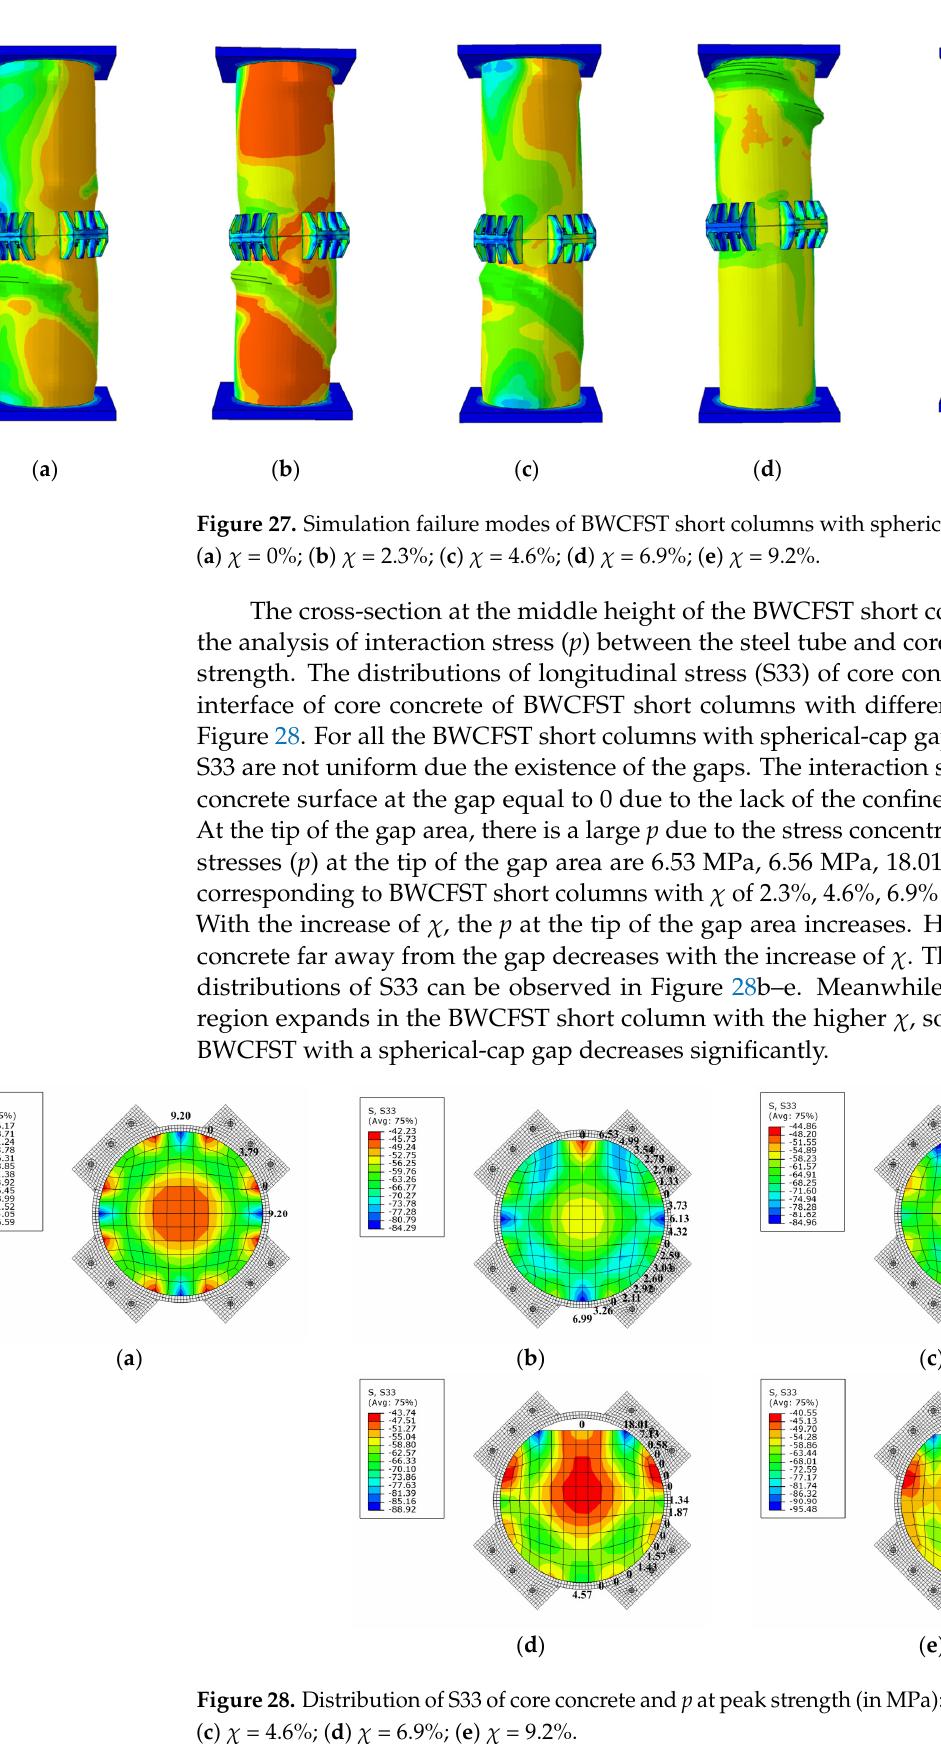
Figure 28. Distribution of S33 of core concrete and p at peak strength (in MPa): ( a )  = 0%; ( b )  = 2.3%; ( c )  = 4.6%; ( d )  = 6.9%; ( e )  =